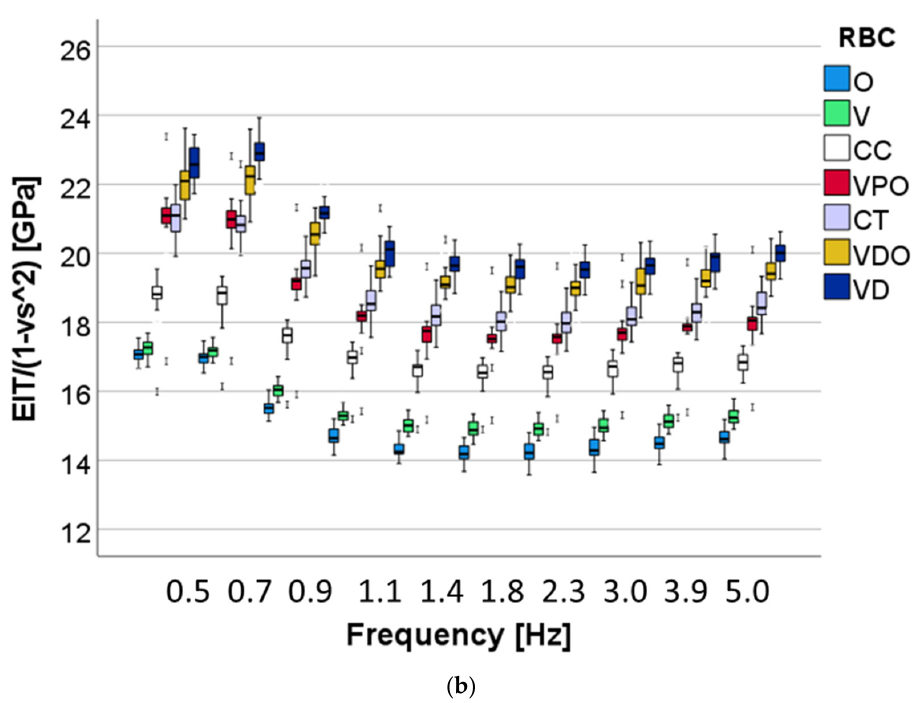
Figure 10. Variation of the indentation modulus as a function of material and frequency in ( a ) unaged and ( b ) after 6 months’ immersion in artificial saliva. The loss factor (Figure 11) also shows a comparable pattern for all materials in its dependence on frequency, with an inverse ordering of the materials compared with the indentation modulus and an increase for all materials after aging.